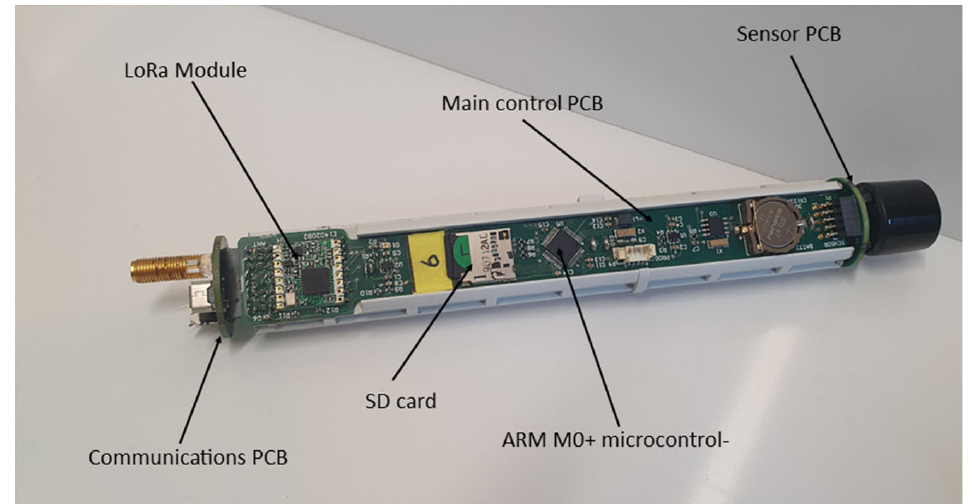
Figure 4. Internals configuration of the sensor probe.